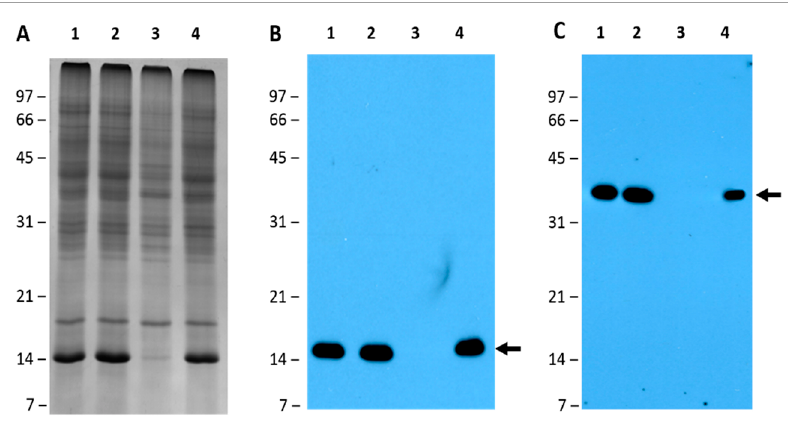
Figure 9. Leghemoglobin and nitrogenase detection by immunoblot analysis. Three identical 15% SDS-PAGE gels were used to resolve pigeon pea total nodule proteins. One gel was visualized by staining with Coomassie Brilliant Blue ( A ) and the other two gels were electrophoretically transferred to a nitrocellulose membrane and probed with either the leghemoglobin antibody ( B ) or nitrogenase antibody ( C ). Immunoreactive proteins were detected using anti-rabbit IgG − horseradish peroxidase conjugate followed by chemiluminescent detection. The arrows point to the proteins reacting to the leghemoglobin and nitrogenase antibody, respectively. Lanes: 1, S. fredii USDA191 nodules; 2, S. fredii USDA RCB26 nodules; 3, B. diazoefficiens USDA110 nodules; 4, B. diazoefficiens ∆ 136 nodules. Molecular weight markers are shown on the left and designated in kDa.